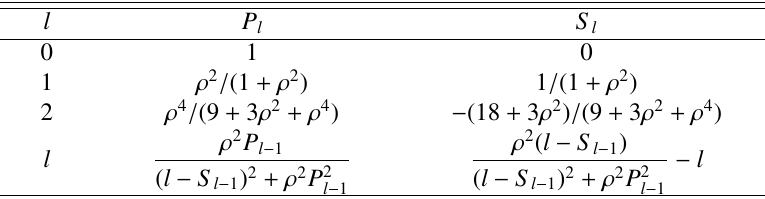
Table 1. Penetration factors P l and level shift S l for di ff erent reaction channels without Coulomb interaction